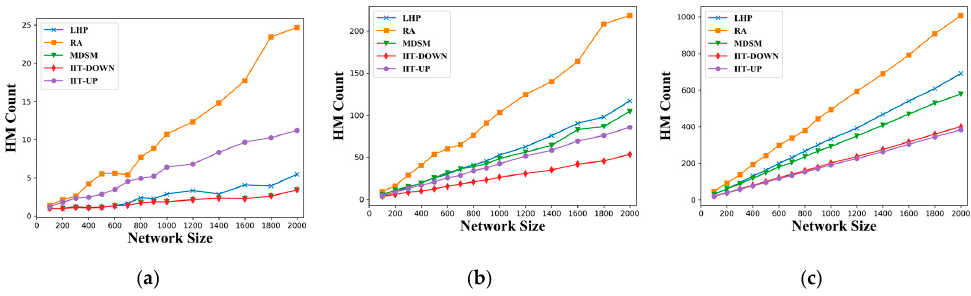
Figure 6. HM count at each layer. In each layer, inter-layer information transfer (IIT) algorithms